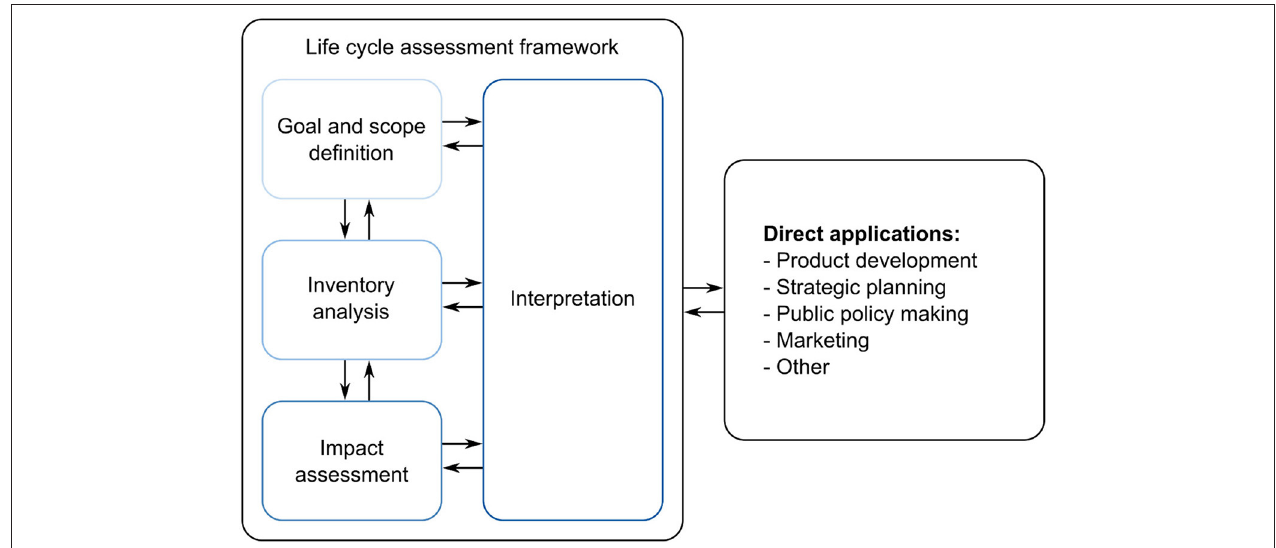
FIGURE 2 | General framework for life cycle assessment (European Committee for Standardisation, 2009).